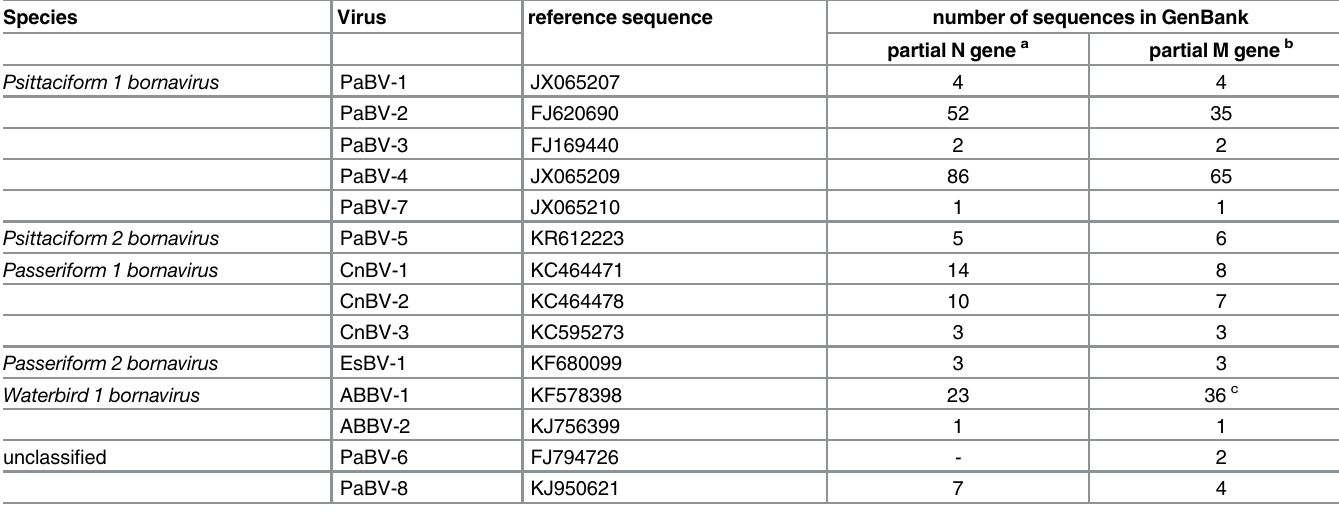
Table 1. Sequences of avian bornaviruses available in